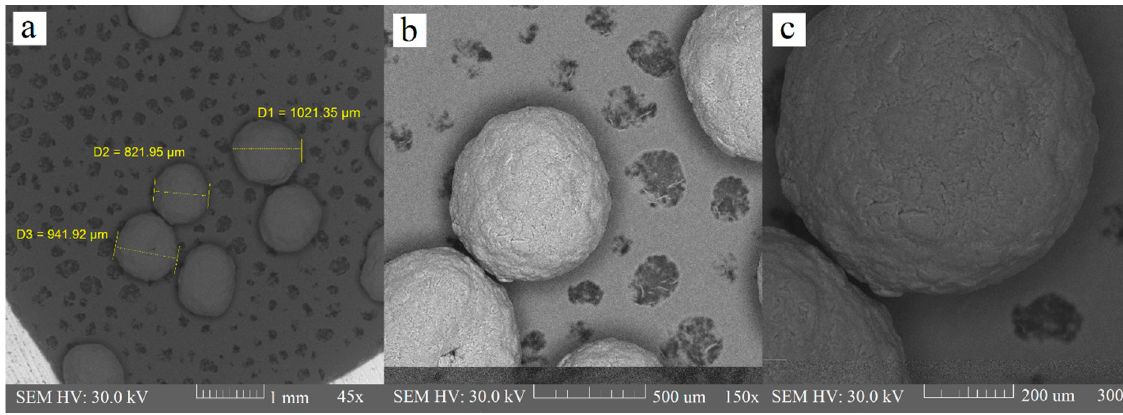
Figure 5. Chitosan pellets at 45× ( a ), 150× ( b ), and 300× ( c ) magnification.